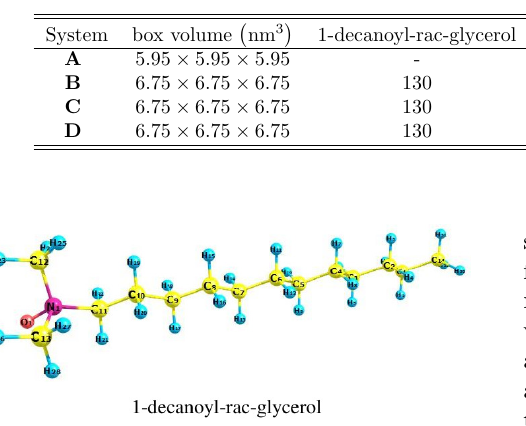
Table 1: Outline of designed systems.